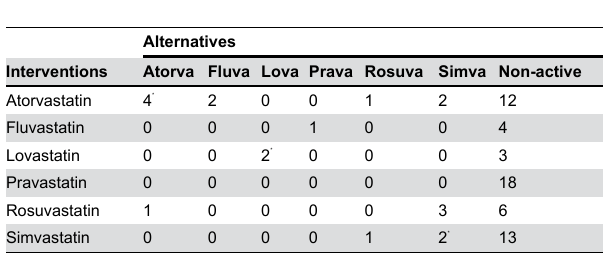
Table 3. Number of cost-effectiveness analyses comparing drug–drug interventions and/or drug-non active control.